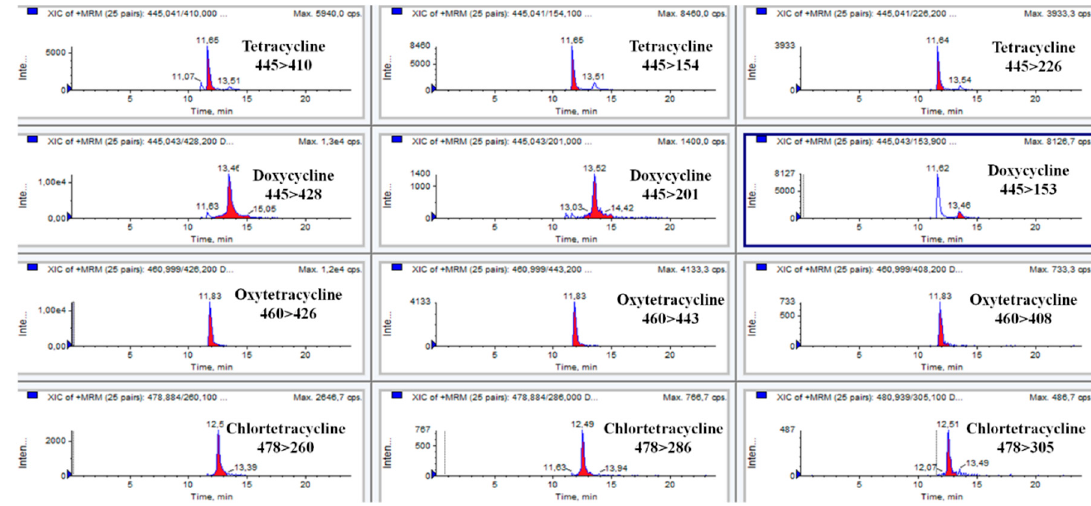
Figure 1. SRM chromatograms of tetracyclines in a blank sample.